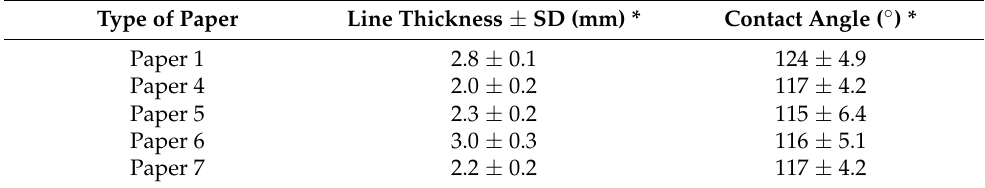
Table 3. Average border line thickness and contact angles on different types of paper using pen